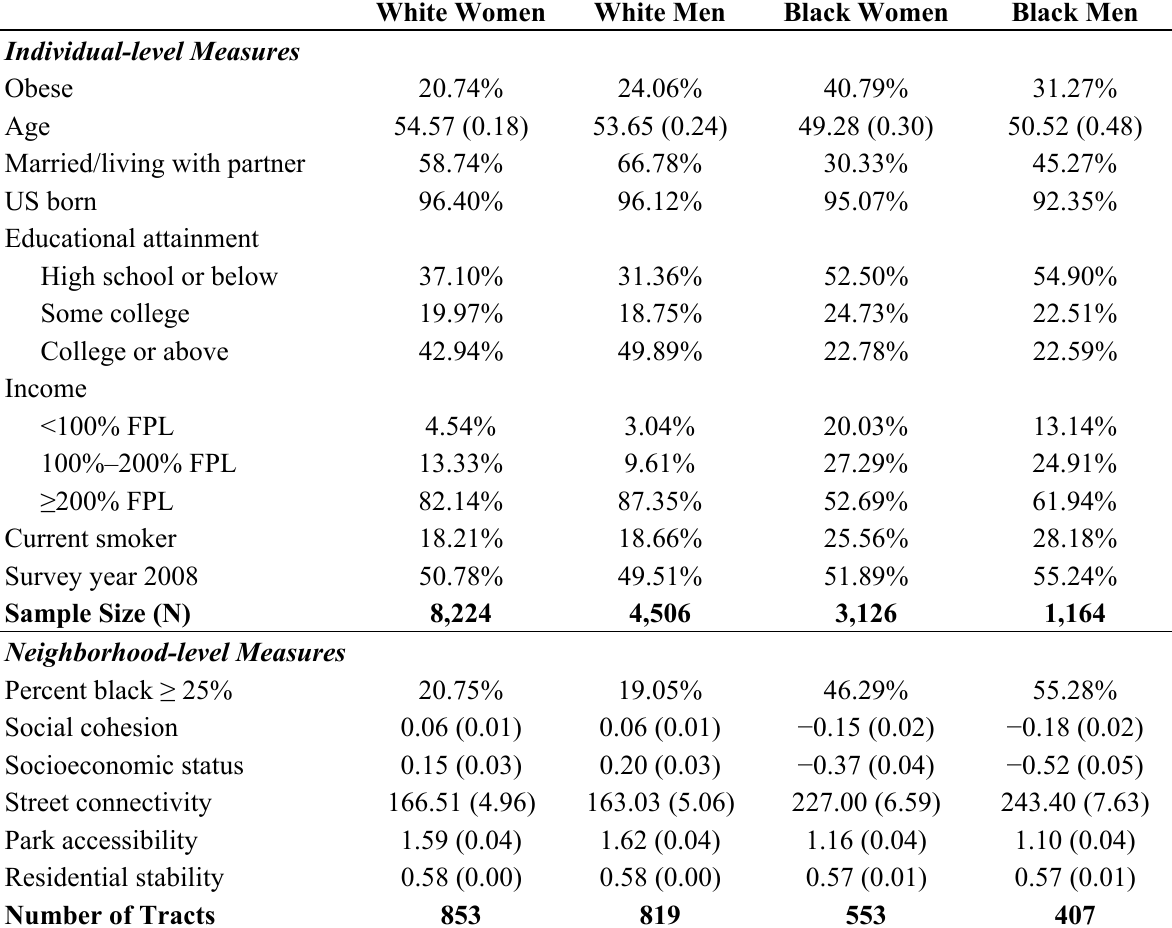
Table 1. Unweighted sample